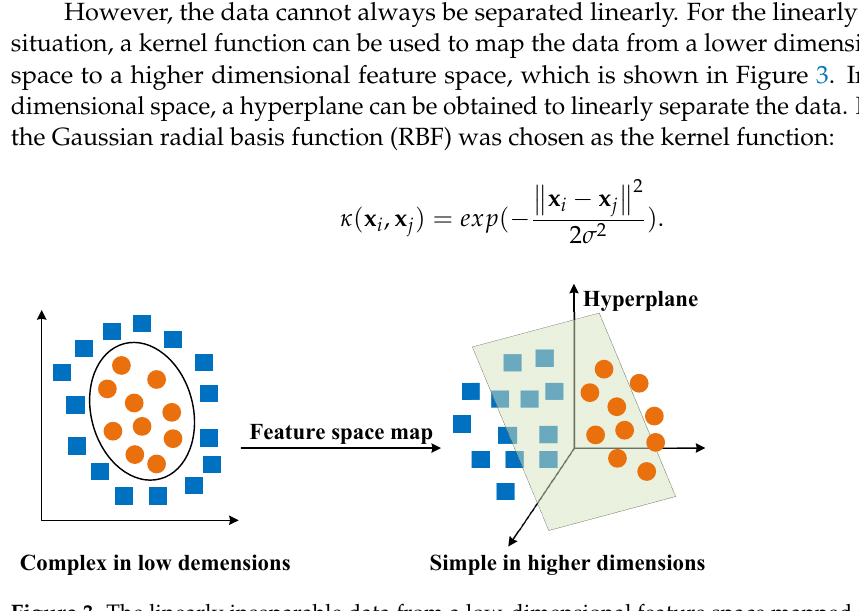
Figure 3. The linearly inseparable data from a low-dimensional feature space mapped to the linearly separable high-dimensional feature space through the kernel